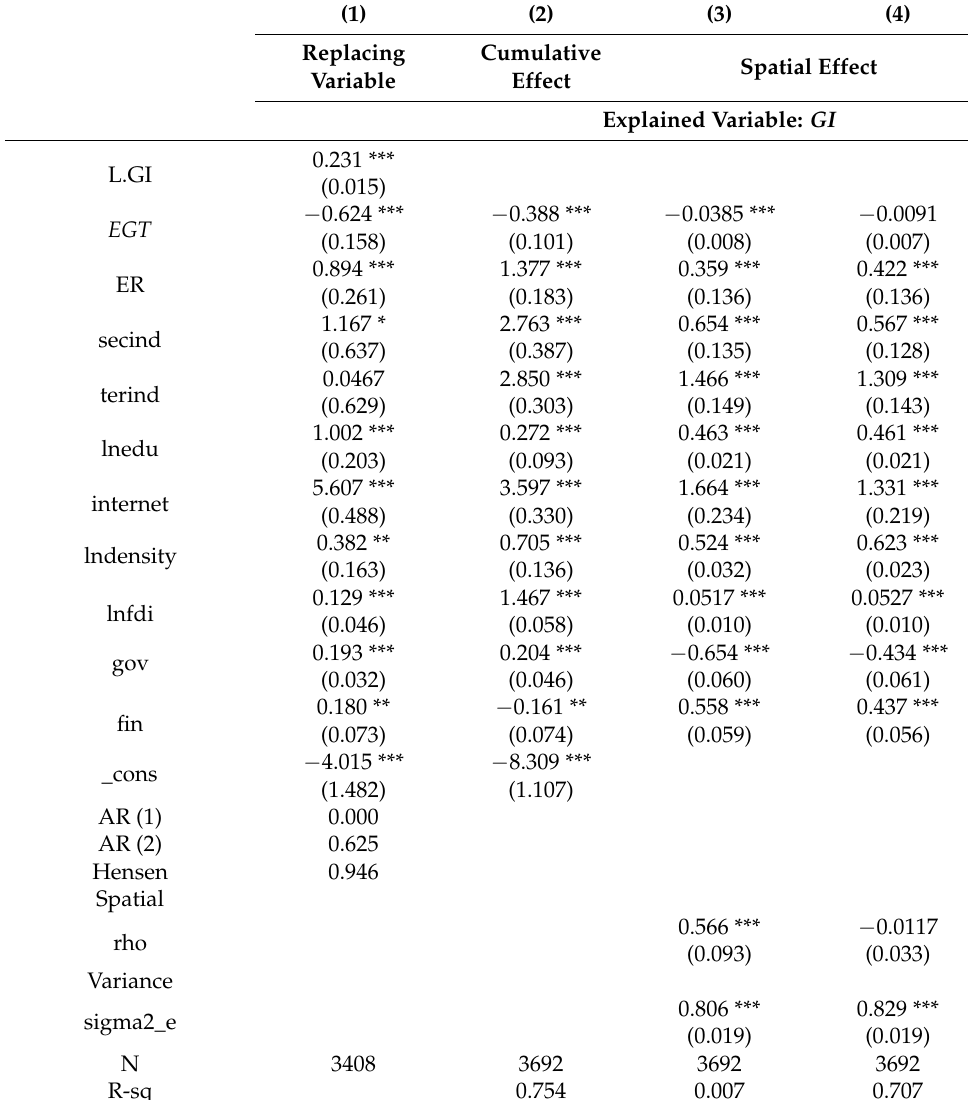
Table 3. Robustness test